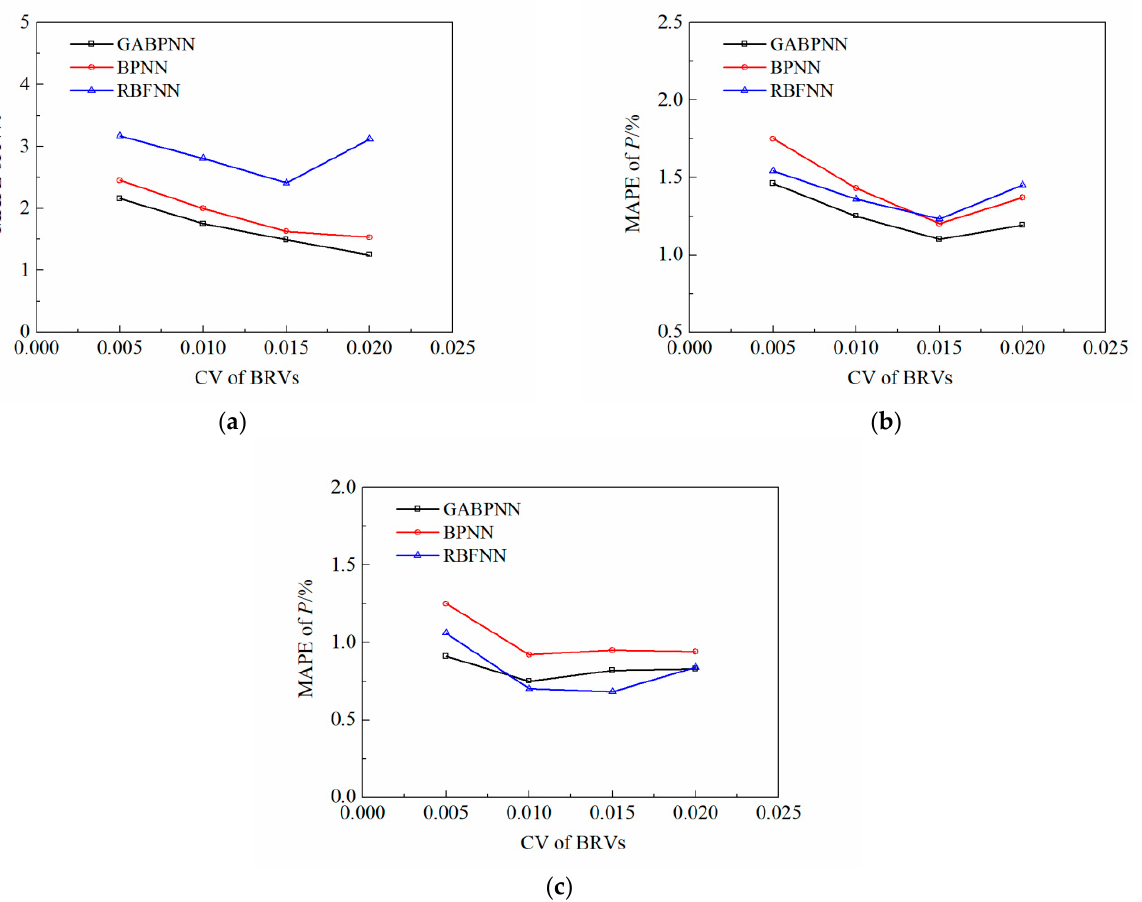
Figure 8. The comparisons of the MAPEs that the ANNs calculate the P ’s of the three gauges in the numerical mode in the DPR study under the shock load condition where v numerical mode in the DPR study under the shock load condition where v is 1050 m/s. ( a ) Gauge 1. 1. ( b ) Gauge 2. ( c ) Gauge 3. ( b ) Gauge 2. ( c ) Gauge Table 7. The comparison of the test results of the ANNs in the DPR study under the shock load __ condition where v is 1050 m/s.